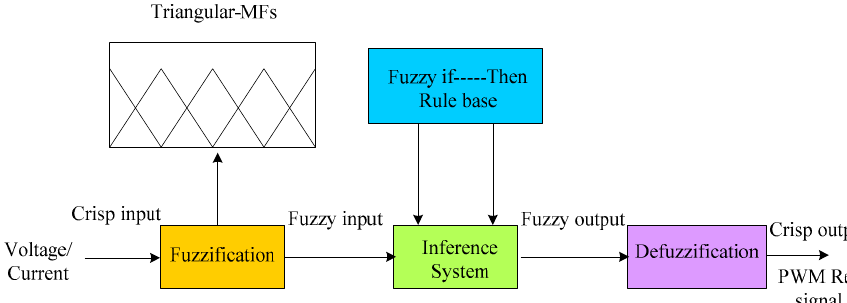
Figure 7. Overview of Fuzzy controller.